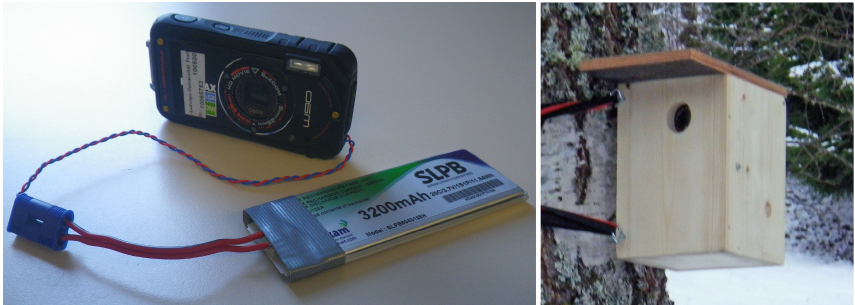
Fig. 2. Camera setup used in the presented study. Set-up of the additional battery (left panel) and installation in the field within a bird house as a protection against the weather (right panel).